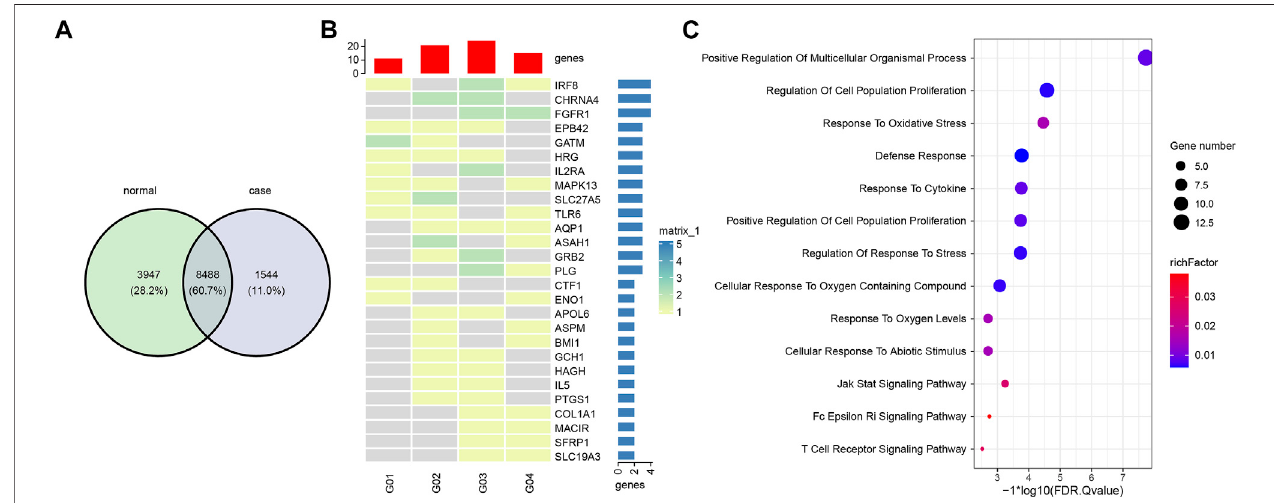
FIGURE5| Comparison andfunctionalanalysisofeccDNA genes. (A) Shared anduniqueeccDNAgenesbetweengoutand healthycontrols. (B) Aheatmapof27 gout unique eccDNA genes involved in in fl ammatory response or potentially gout-related diseases. (C) Functional enrichment of 27 gout unique eccDNA